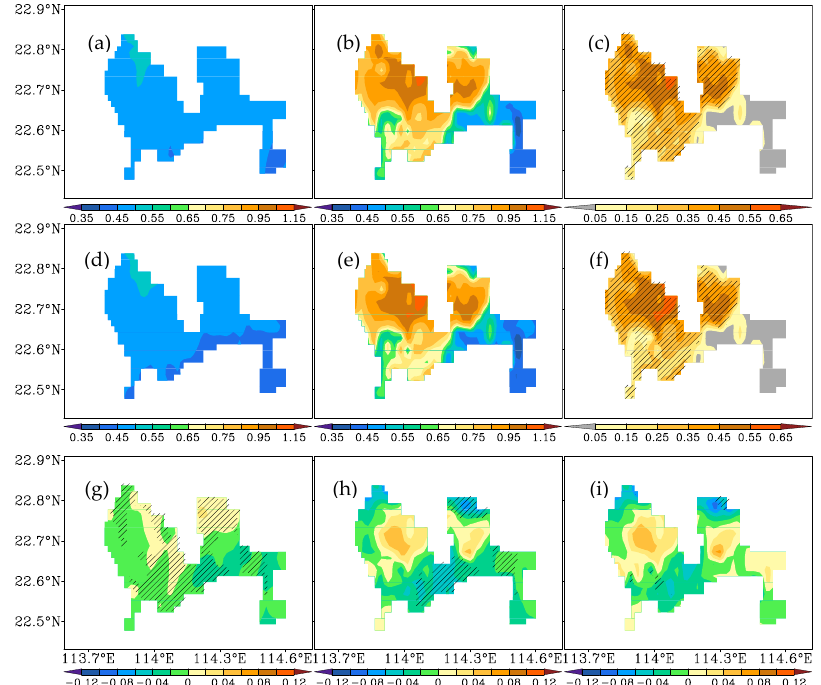
Figure 6. Trends in ( a , b ) T 4 and ( d , e ) T xn , and ( g , h ) the corresponding differences (T xn minus T 4 ) under ( a , d , g ) EX1 and ( b , e , h ) EX2 for 1980 and 2016. ( c , f ) The urban-related warming contributions for ( c ) T 4 and ( f ) T xn , and ( i ) the corresponding differences over Shenzhen (oblique line denotes passing the 90% confidence level significance t -tests, units: °C/decade).